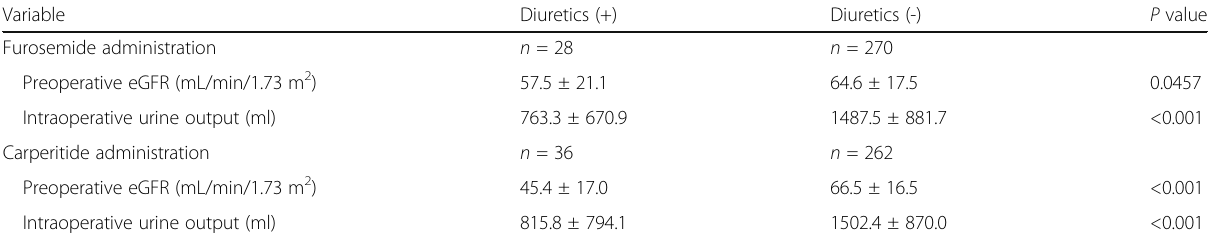
Table 5 The patients demographics given the furosemide or carperitide during surgery.